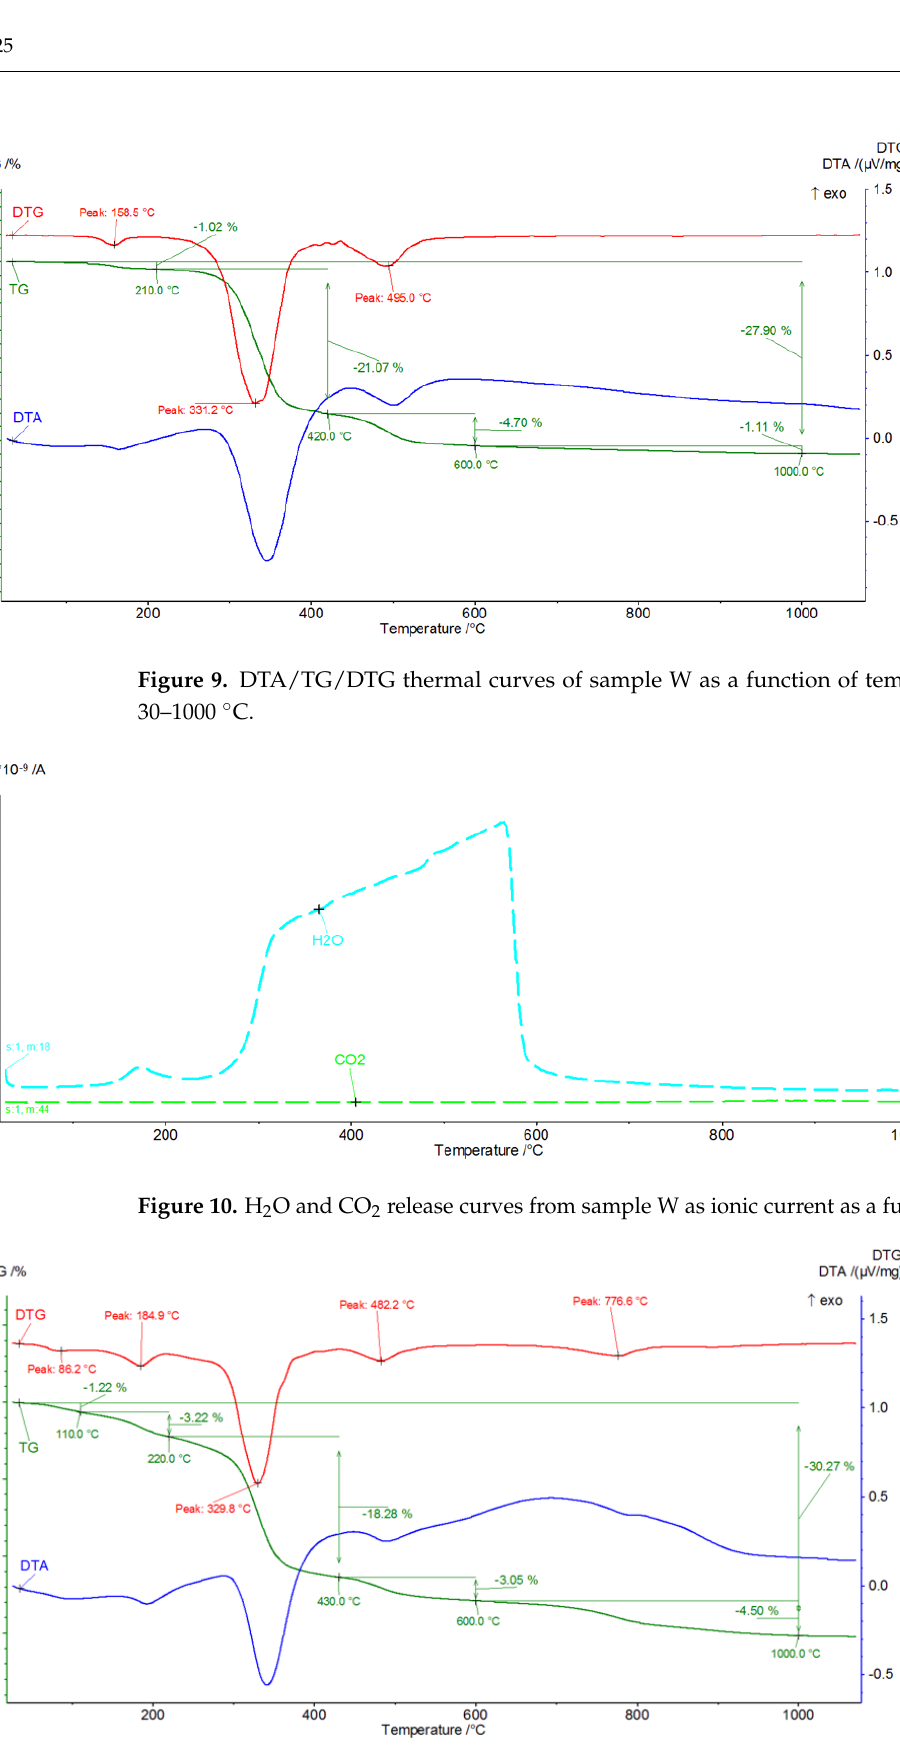
Figure 11. DTA/TG/DTG thermal curves of sample G as a function of temperature in the range 30 – 1000 °C.